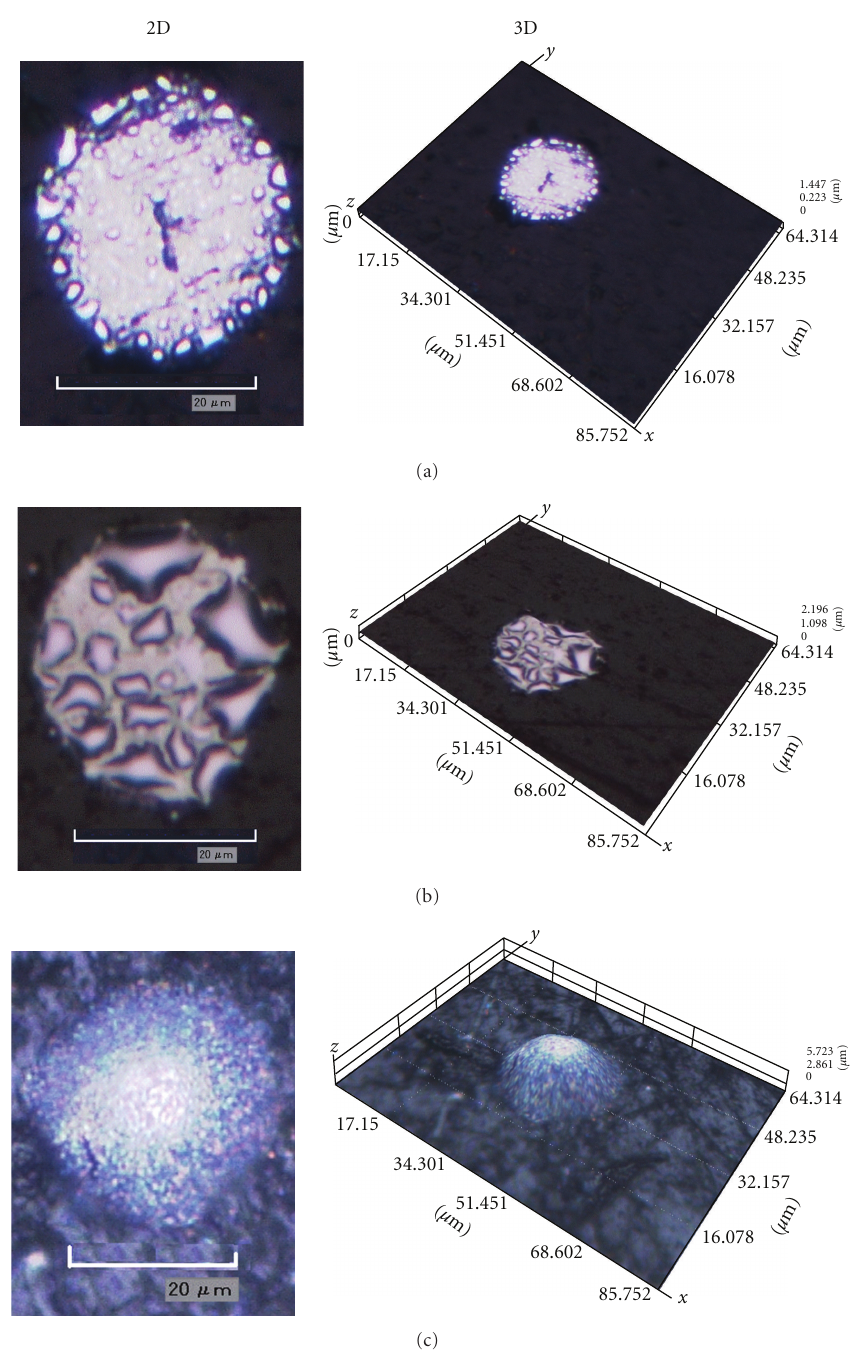
Figure 1: Photographs obtained via optical microscopy (magnified 2500 times) of the mercury film electroplating on the Pt-UME surface in mercurous solution at − 0.1 V versus Ag/AgCl in 2D and 3D; deposition times were (a) 5 s, (b) 25s, and (c) 300 s.